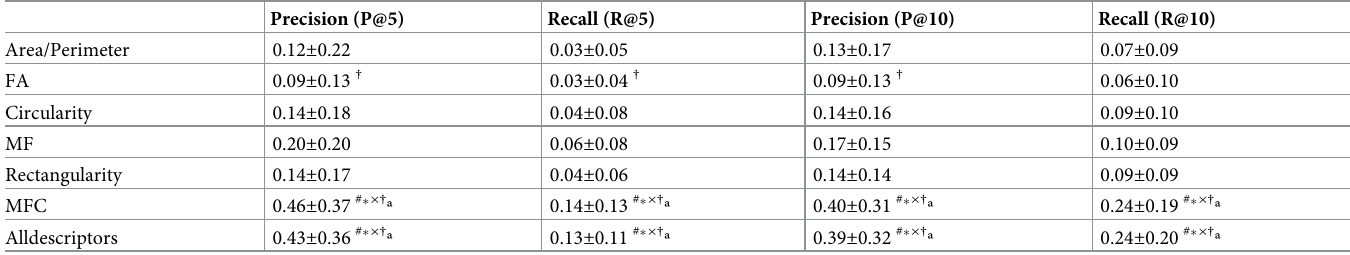
Table 3. Values of mean ± standard deviation for precision (P@5 and P@10) and recall (R@5 and R@10) for evaluating the efficacy of different